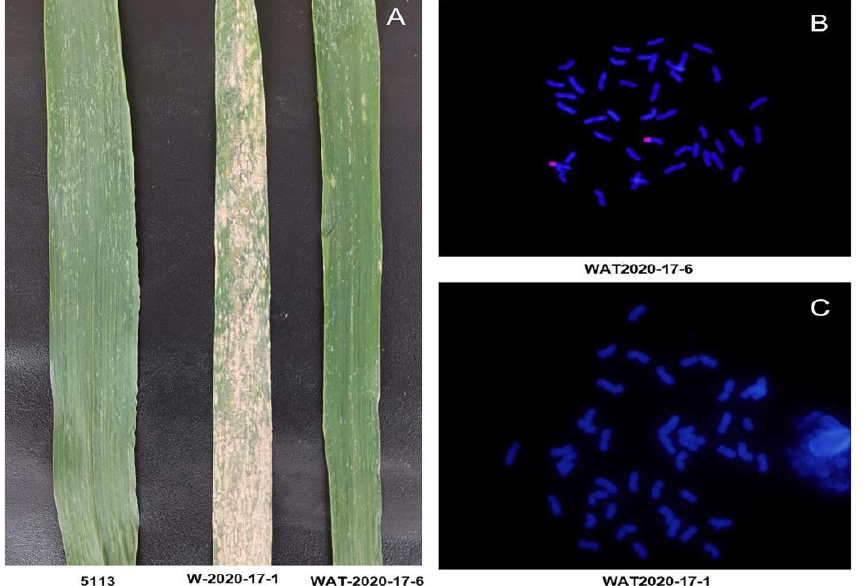
Figure 1. Evaluation of powdery mildew resistance and cytological identification of WAT-2020-17-6 and W-2020-17-1. ( A ) Disease responses to powdery mildew of 5113, WAT-2020-17-6 and W-2020-17-1. ( B ) GISH patterns showing WAT-2020-17-6, including a pair of translocation chromosomes. ( C ) GISH patterns showing W-2020-17-1, including 42 wheat chromosomes.